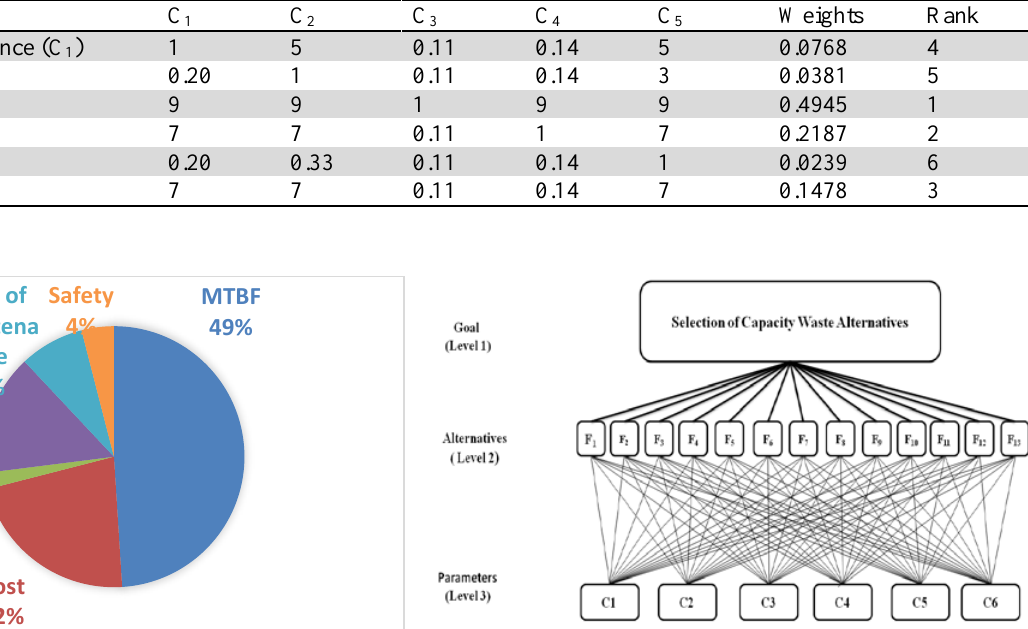
Subjective weights of the evaluation criteria calculated using AHP